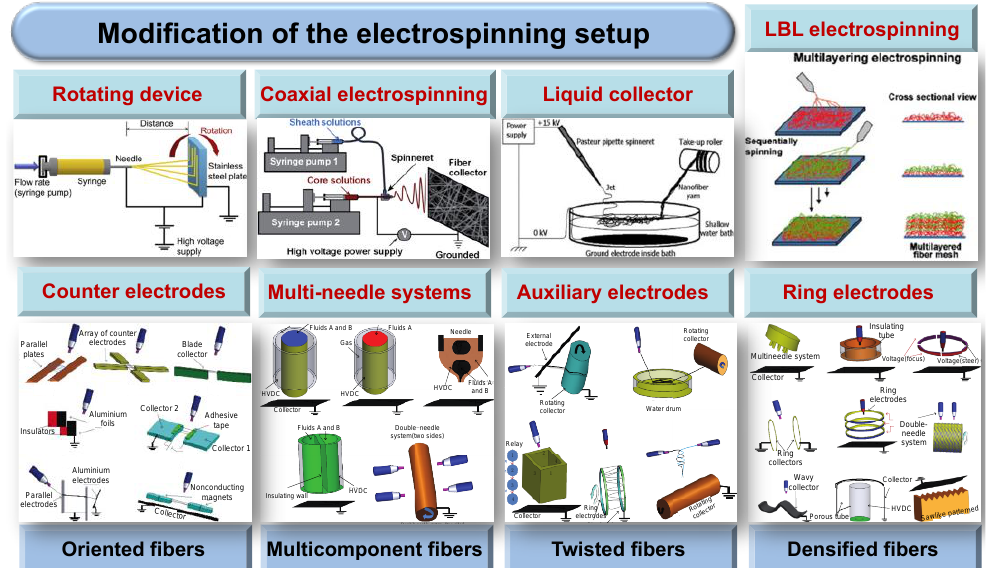
(i)Multineedlesystem Double- Figure11:Setupstocontrolthedepositedareaanddensityofelectrospun fi ber,(a)regularhexagonmultineedlesystemenclosedinsideanironring,(b)insulatingtubearoundtheneedlesystem,(c)groupoffocusingandsteeringelectrodesplacedclosetocollectingsubstrate,(d)dualrings,(e)threerings,(f)2-needlesystem,(g)wavy-shapedcollector,(h)porous-walledcylindricaltubeasthedispensingsystem,and(i)sawlike-patterneddispensingsystem. Figure12:Thefunctionofthemodi fi edsetupistoproducemulticomponent fi bers,(a)coreshell,(b)gasasashellmaterialincore-shellstructure,(c)single-needlecoreshellstructure,(d)bicomponentelectrospinningsystem,and(e)rotatingdrumbetweentwoneedlesystemsaselectrospinningsetup. Figure15:Thesesetupsareemployedtoproducetwistednano fi bers,(a)self-bundlingelectrospinning,(b)electrospinninginaliquidcontainertoneutralizethefreecharges,(c)twistingbyfourauxiliaryelectrodes,(d)ringcollector,and(e)twohorizontalneedlessystems. ofhomogeneously mixed superhydrophobiccompositenano fi bers.Duanetal.[69]ontheotherhand,wasabletocon Thoughthecore-shellandbicomponentnano fi bersarequitepromising,the fi nal fi bermorphologylargelydependsuponthe Acknowledgments fi guremechanicallystablehighlyhydrophilicmembraneswiththesimilarelectrospinningsetup.In-housedesignedcore-shellsetupwasemployedfortheproductionofcore-shellaswellashollow fl uiddynamicsintheboundarylayerattheinter-faceofthedissimilar fl uidcomponents.Athickboundarylayerattheinterfacewillimplyalargedragforceactingontheinner TheauthorsgratefullyacknowledgeNationalUniversityof Singapore,NanyangTechnologicalUniversity,andNational fi bersshowninFigure13.These fi bersarebeingemployedfortheadvanced fl uidcomponent.Thislargedragforcewillimpedethe fl owofinner fl uidcomponentresultinginpredominately Figure 4. A schematic diagram of the modified electrospinning set-up. Reproduced from [145] with ResearchFoundation,Singapore,forfundingsupportofthe researchGrant(NRF-CRP-4-2008-03). Figure 4. A schematic diagram of the modified electrospinning set-up. Reproduced from [145] with applicationsuchasphotocathodesindye-synthesizedsolarcells,gassensors,andregenerativemedicineapplications.Hollow singlecomponentnano fi bers,thusdefyingthepurposeofthedesignedsetup.Thisimpliesthatpropercontrolofprocessandsystemparameterssuchas fi bersobtainedwereemployedasphotocathodesinDSSCsduetotheirlargesurfaceareatothevolumeratio.Thislargesurfaceareaofthehollow fl owrateandchemicalcom-positionofthesolutionsisrequiredfortheproductionofcore-shell fi bersresultsintheim-proveddyeloadingofthephotocathodeandthusimprovedperformanceofthesolarcells.Theabovementionedworkwillappearelsewhere.Workisalsointheprocesstoemploycore-shell fi bers.Compositenano fi bersarealsobeingobtainedthroughchemicalsynthesisbyemployingelectrospun permission from Elsevier Ltd.; Copyright 2008. Reproduced from [146] with permission from Future permission from Elsevier Ltd.; Copyright 2008. Reproduced from [146] with permission from Future fi bersasthebasematerial.Forinstance,Sebastianetal.[70](co-re-searcheratNUSNNI,NUS,Singapore)fabricatedefficientcatalytic fi berinthesolidstatesolarcells,webguides,gassensors,andsoforth. fi ltermembraneemployingnano fi bersasshownin Science Group; Copyright 2012. Reproduced from [140] with permission from Elsevier Ltd.; Science Group; Copyright 2012. Reproduced from [140] with permission from Elsevier Ltd.; Copyright Copyright 2005. Reproduced from [129] with permission from Elsevier Ltd.; Copyright 2005. 2005. Reproduced from [129] with permission from Elsevier Ltd.; Copyright 2005. Reproduced Figure13:(a)TEMofcore-shell fi berspreparedbycoaxialelectrospinning.10wt%aqueouspolyvinylalcohol(PVA)wasemployedasthecore,whereas8wt%polyvinylpyrrolidone(PVP)dissolvedindimethylformamide(DMF)astheshell.Theelectrospinningwasperformedattheappliedelectric fi eldstrengthof1.5kV/cm,(b)SEMimageofthehollowTiO 2 nano fi bers. Reproduced from [147] with permission from Hindawi; Copyright 2011. from [147] with permission from Hindawi; Copyright